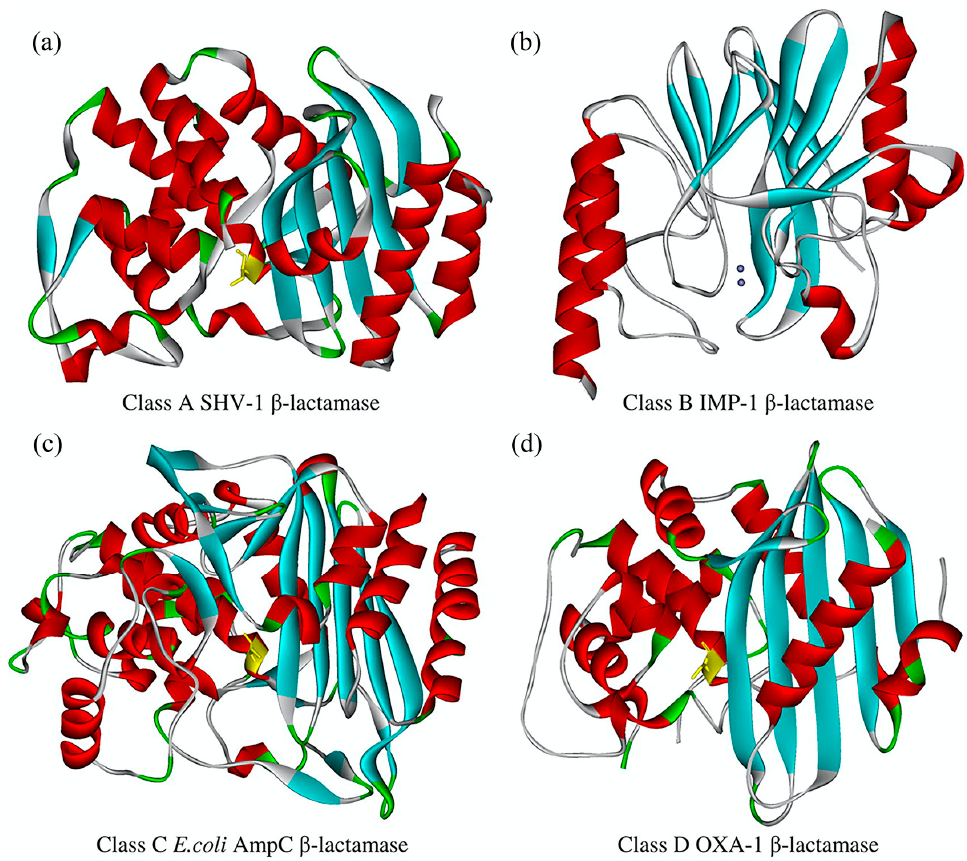
Figure 1. Overall structure of representative β -lactamases from A, B, C, and D classes (adapted from reference 92 with permission). ( a ) Class A SHV-1 (sulfhydryl reagent variable-1); ( b ) class B IMP-1 (imipenem-resistant Pseudomonas-1); ( c ) class C (AmpC (ampC β -lactamase); ( d ) class D OXA-1 (oxacillinase-1). Active sites of the serine- β -lactamases are colored yellow, and the metallo- β -lactamase zinc ions are shown as gray spheres.